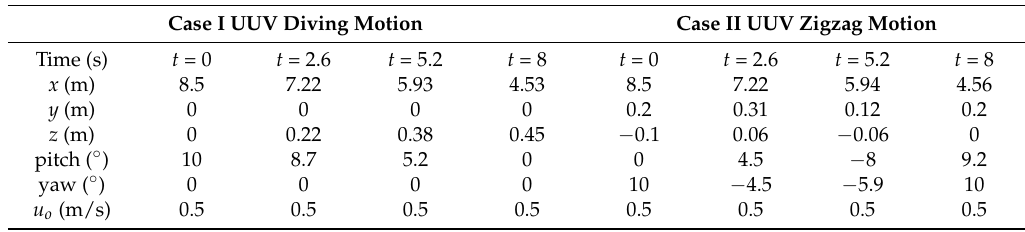
Table 2. UUV Reference trajectories used in the Monte Carlo simulations.